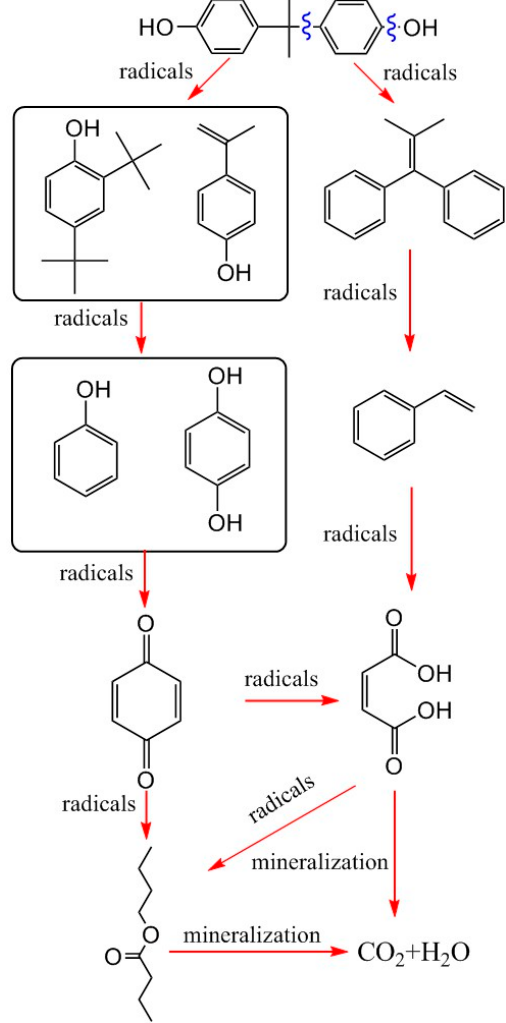
Figure 4. Possible degradation pathways of BPA in Fenton-like systems. Reaction conditions: pH = 5.0, [BPA] 0 = 0.2 mM, [Fe 0 ] 0 = 7 mM, [H 2 O 2 ] 0 = 6 mM, [Cl − ] = 2 mM. Radicals in the figure represent HO • , Cl • , and Cl 2 •− . The chlorinated products were not detected during the reaction, suggesting that the addition of Cl- is not the main reaction mechanisms of BPA degradation. As the chlorinated compounds are thought to be highly toxic, the WMF-Fe 0 /H 2 O 2 is expected to decrease the toxicity of the BPA